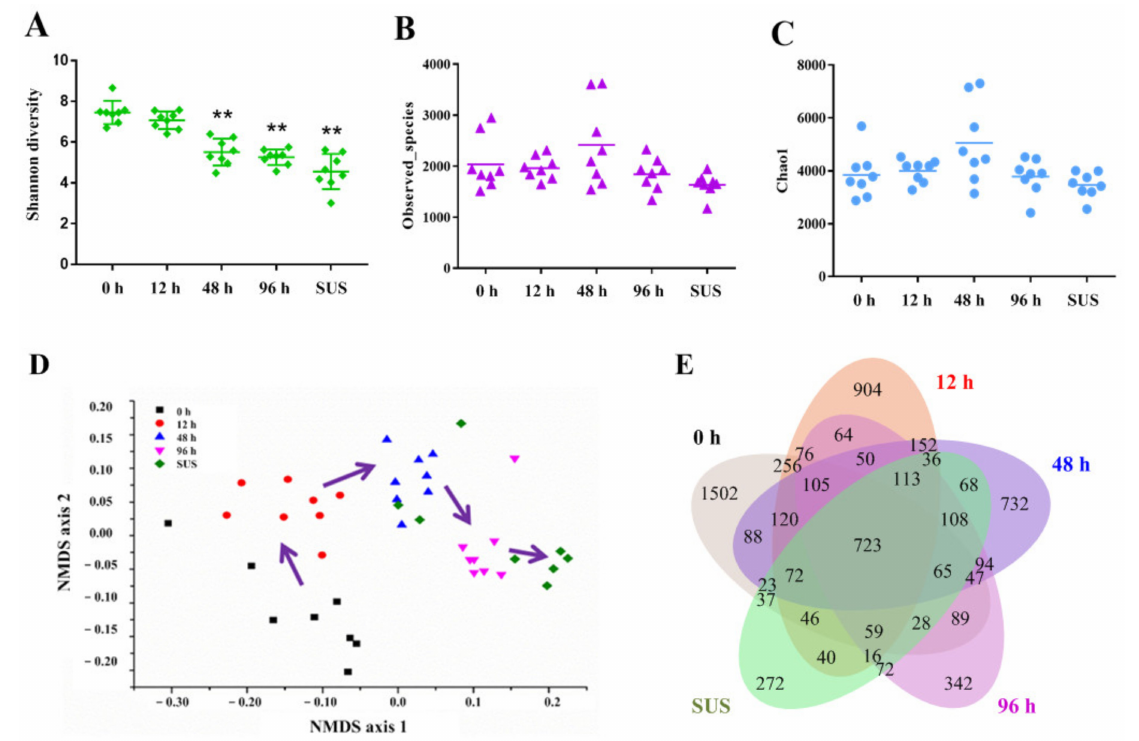
Figure 2. V. splendidus infection adjusted the gut microbiota in sea cucumber. ( A ) Shannon diversity index after 48 h groups. ( B ) Observed_species index and ( C ) Chao1 index have no significant differences. ( D ) Non-metric multidimensional scaling (NMDS) of the gut microbiota after V. splendidus infection. ( E ) Overlap between detected species among the different groups after V. splendidus infection of the sea cucumber. Asterisks indicate significant differences: ** p < 0.01.